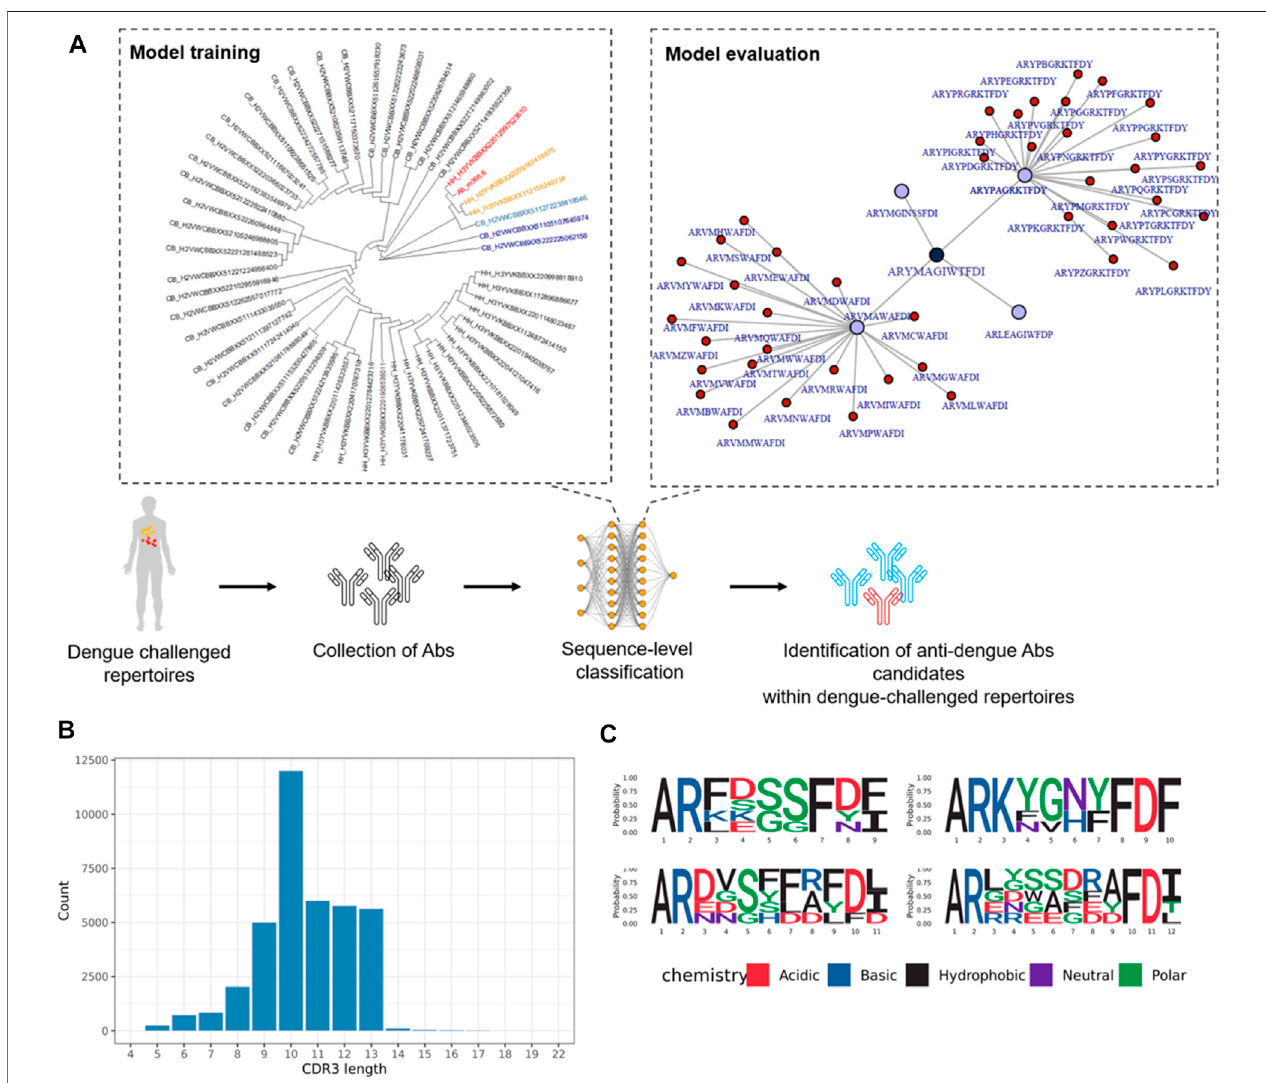
FIGURE 7 | Dengue-speci fi c antibody sequences generated with network analysis and machine learning. (A) Sequences with highest similarity to Ab m366.6 are showninredandmoredistantsimilarsequencesareshowninorangeandblue. (B) CDR3a.a.lengthofdengue-speci fi cclassi fi edantibodysequences. (C) Logo-plotof the top 20 dengue-speci fi c classi fi ed